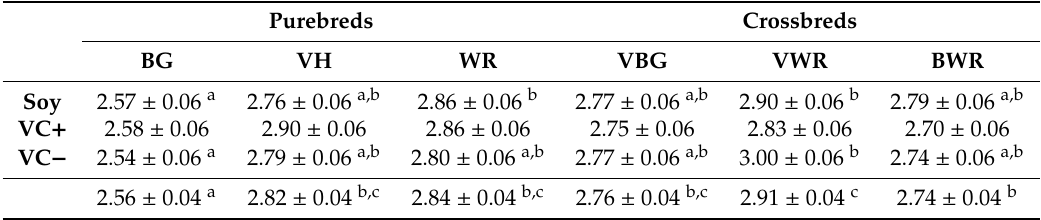
Table 5. Least square means ( ± SE) for feed conversion ratio (FCR in kg / kg) from week four to ten by genotype × feeding treatment and by genotype.